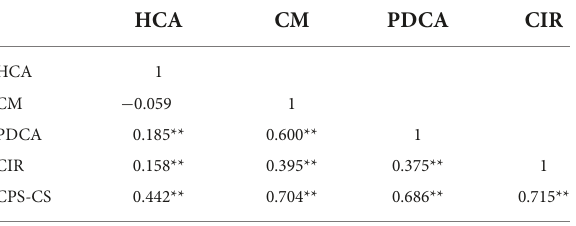
TABLE 3 Correlations among dimensions of